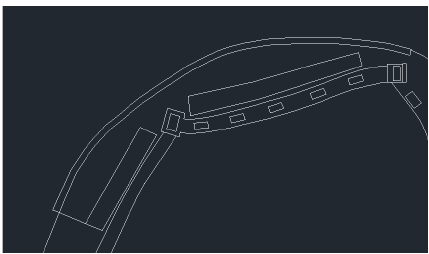
Figure 3.2 Flat stone digitized from 3D point cloud model